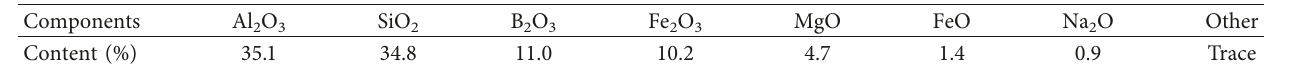
Table 2: The main chemical components of TAP.